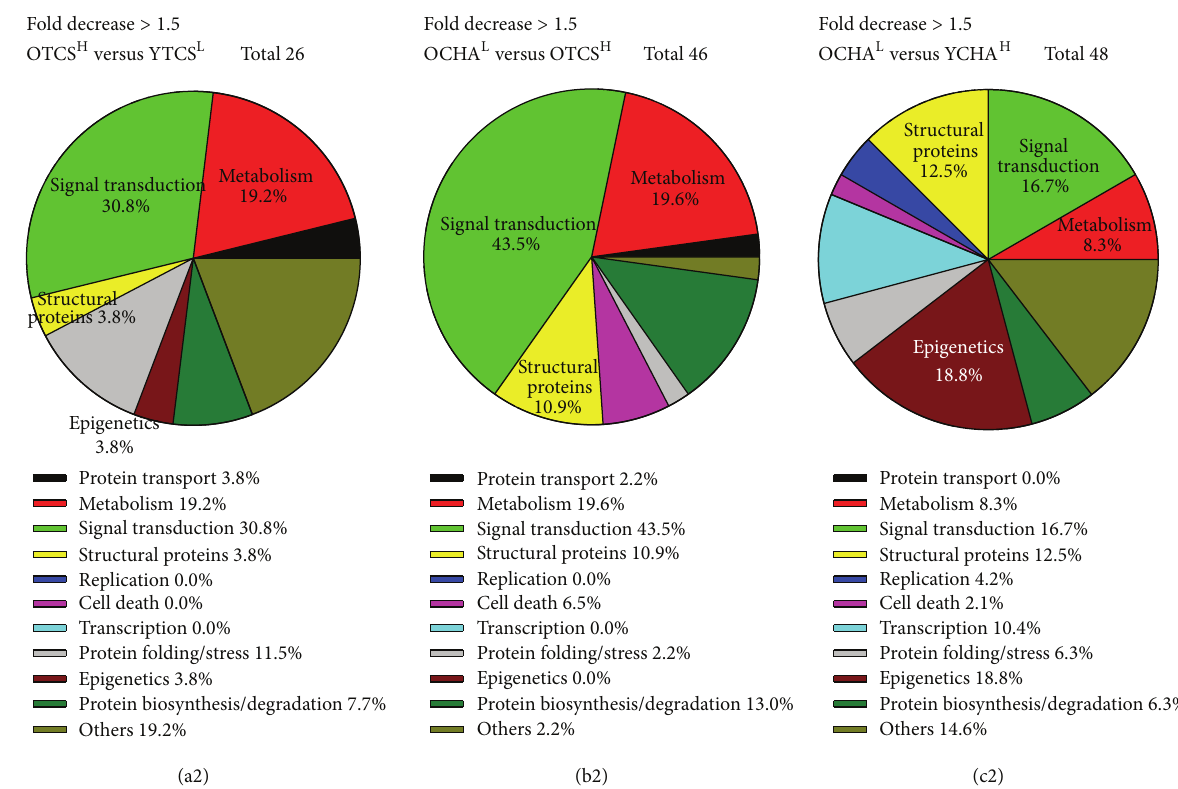
Figure 3: The aging phenomena in HA absence detected high percentages of signal transduction and structural proteins. Pie charts representing the total proteins identified with ratio above 1.5 in the (a) OTCS H versus YTCS L , (b) OCHA L versus OTCS H , and (c) OCHA L versus YCHA H groups, respectively. (a1) The OTCS H had 0% of replication-related proteins, showing that replication had slowed down or ceased. (a2) The upregulated proteins in OTCS H had 30.9% of structural proteins and 3.8% of downregulated proteins cell structural. Cell structure may have played a major role in the aging cells. (b1) In comparison to OTCS H , OCHA L had 10.4% upregulated proteins of biosynthesis/degradation proteins, which correlated with the high percentage of metabolic proteins (20.8%), indicating that OCHA L had higher metabolic activity. (b2) The group OCHA L had 43.5% downregulated proteins for signal transduction. (c1) The metabolic activity (28.1%) in OCHA L was higher compared to YCHA H , which may have correlated with the protein biosynthesis/degradation activity of 18.8%. The aging phenomena in the OCHA H differed from that in OTCS H in (a1), where the upregulated 12.7% of metabolic and 1.8% biosynthesis/degradation proteins. (c2) Epigenetics consisted 18.8% of the downregulated proteins in OCHA L , suggesting